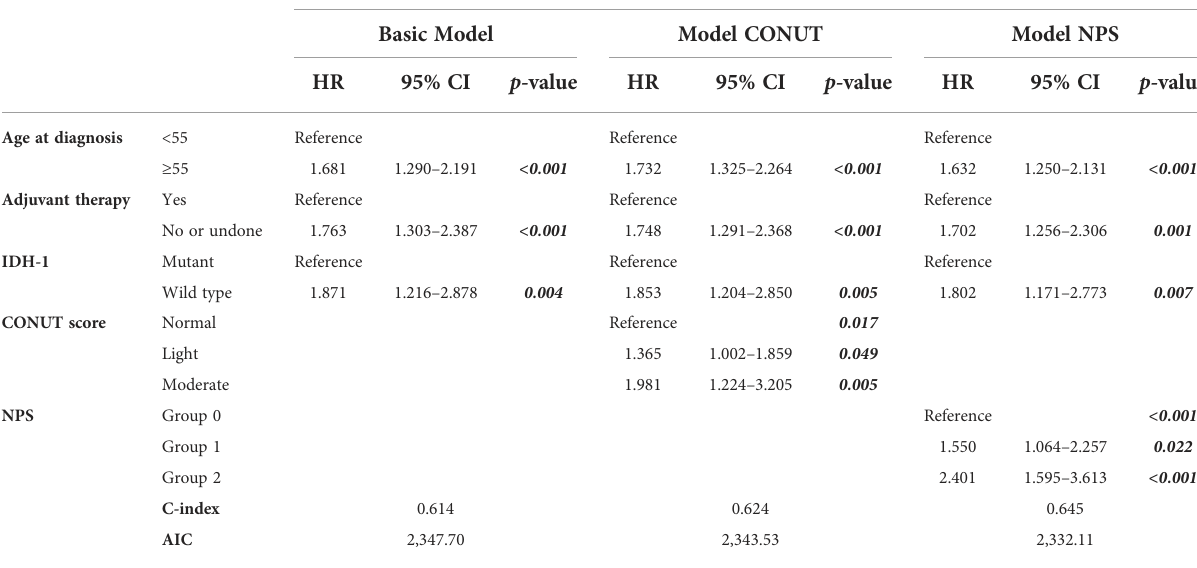
TABLE 3 Prognostic models with NPS and CONUT score for GBM patients. Clinical